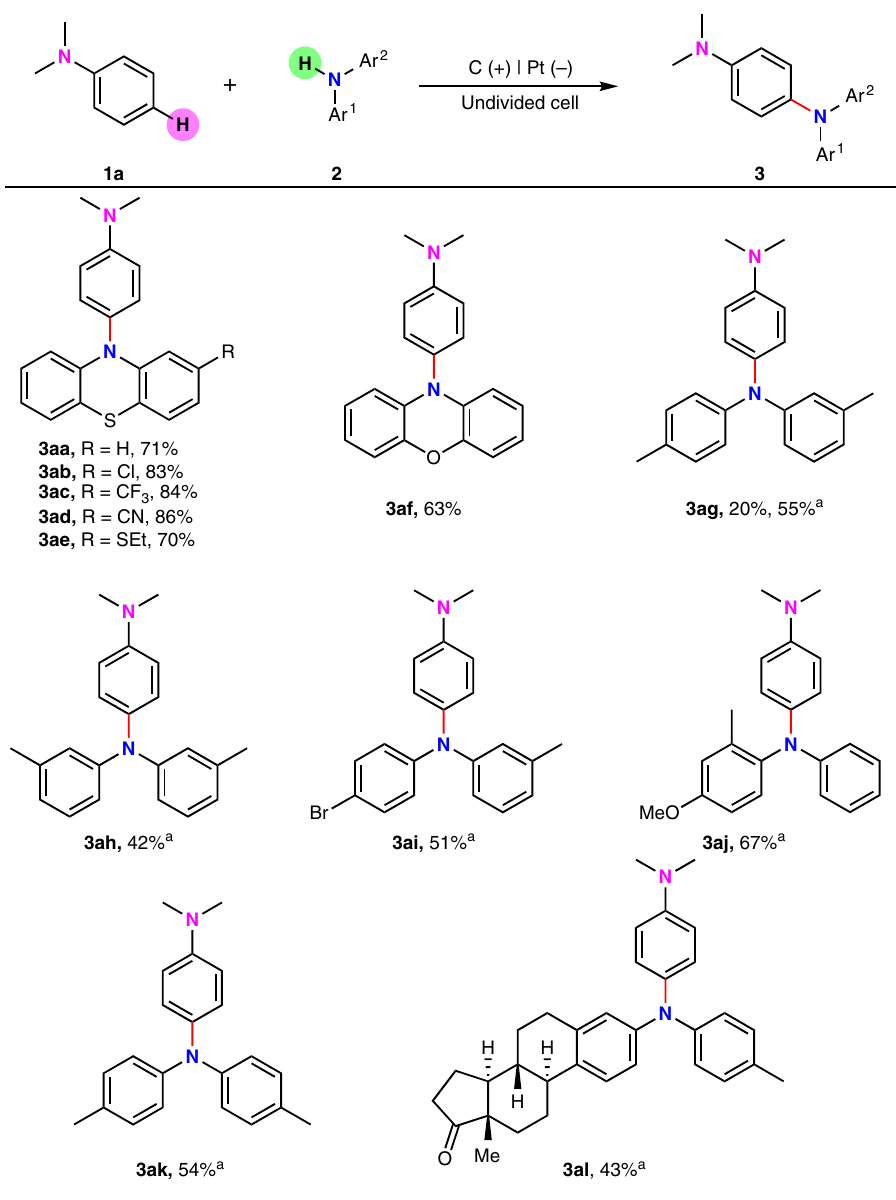
Fig. 2 para -Selective C – H amination of N,N -dimethylaniline with different diarylamine derivatives. Reaction conditions: graphite rod anode ( ϕ 6 mm), platinum plate cathode (15 mm × 15 mm × 0.3 mm), constant current = 7 mA ( J anode ≈ 7.8 mA cm − 2 ), 1 (0.30 mmol), 2 (0.20 mmol), n Bu 4 NBF 4 (0.15 mmol), MeCN/MeOH (7.0 mL/3.0 mL), room temperature, N 2 , 2.0 h (2.6 F). Isolated yields were shown. a Constant current = 12 mA ( J anode ≈ 13.3 mA cm − 2 ), HFIP/MeCN (5.0 mL/5.0